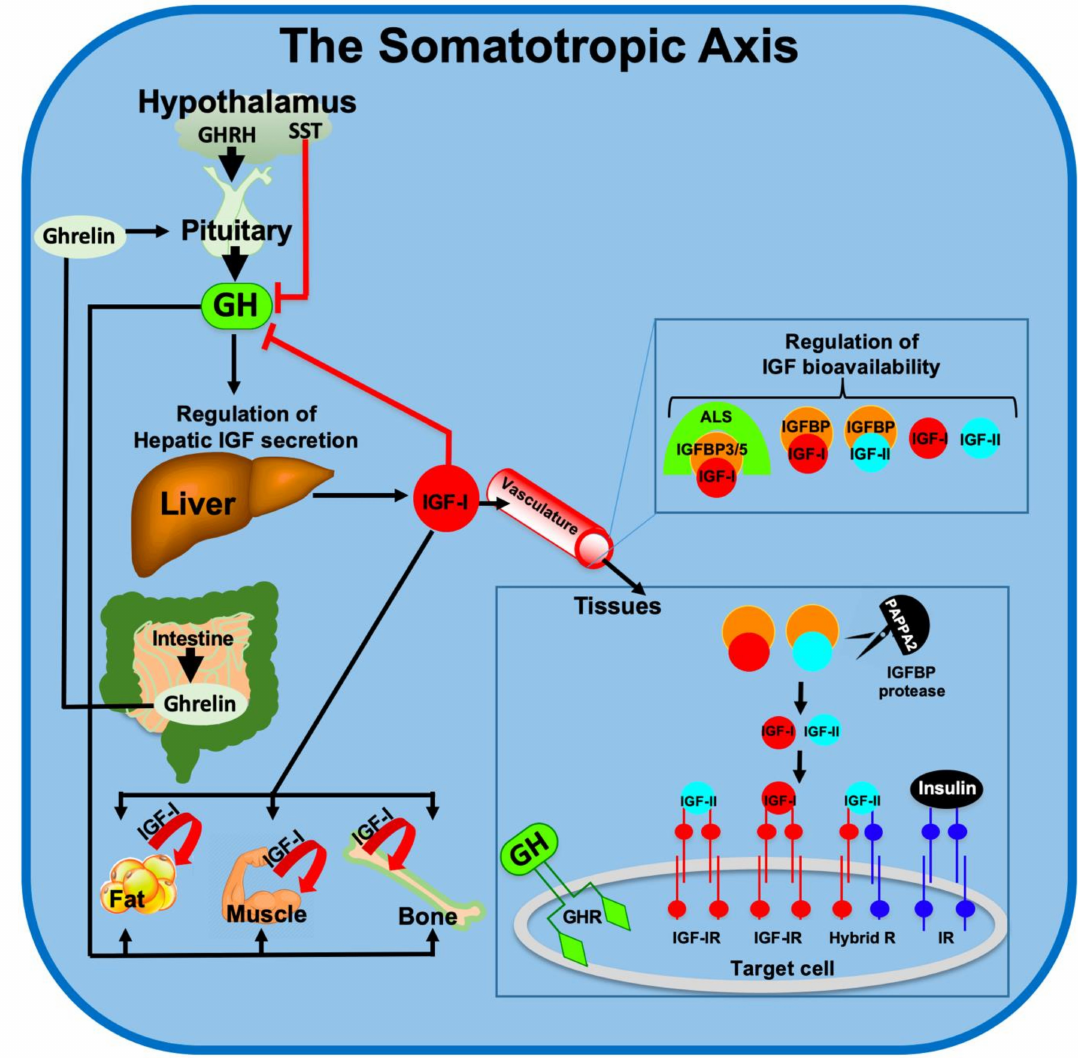
Figure 1. Schematic summary of the major molecules composing the